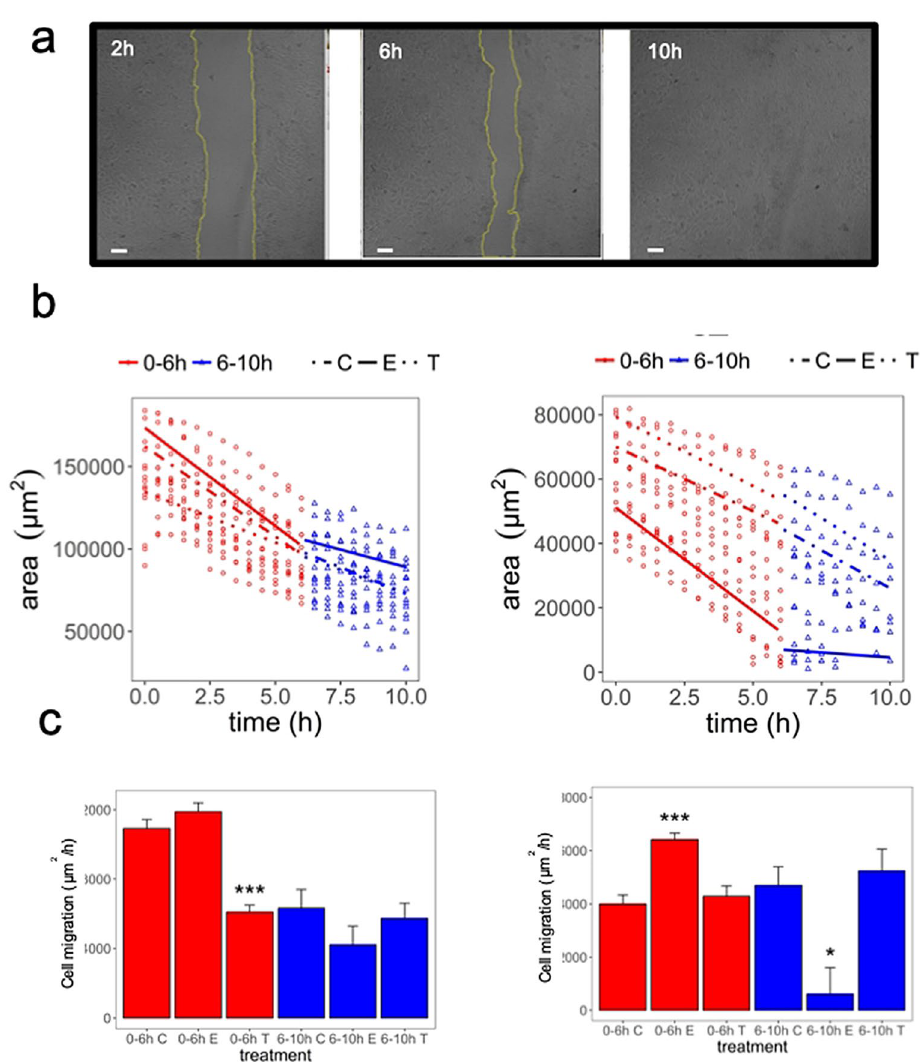
Figure 4. Scratch assay. ( a ) HACAT cell images from a wound-healing experiment at different time points. As an example, EGF treated cells at 10 ng/mL are shown at 2, 6, and 10 h. Scale bar = 100 μm. ( b ) T98G and HACAT cell images in a time series were analyzed for gap area over time. Linear mixed regression to model the rates of wound healing across time is shown. ( c ) The cell migration rate for T98G and HACAT cells is shown. Values in brackets stand for compound concentration in mg/mL. C control, T tip portion, E EGF. Data are means ± SEM (n = 2). P -value of the significant pairwise comparison against control ( + P = 0.1–0.05, * P = 0.05– 0.01, ** P = 0.01–0.001, *** P ≤